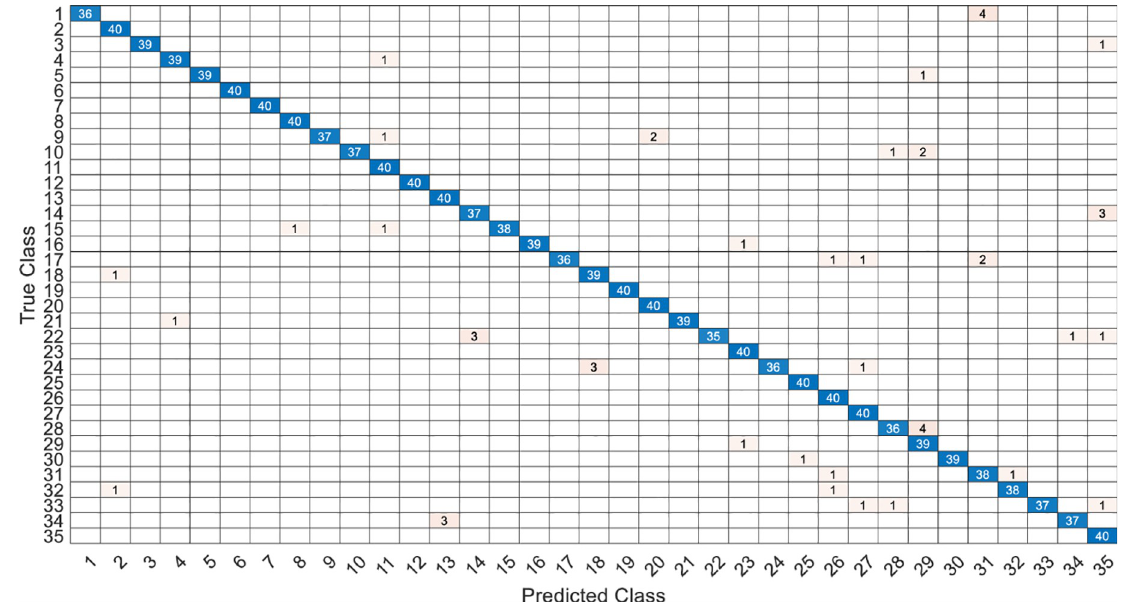
Fig 34. The confusion matrix of PCA-DNN-12-layer model with MFCC datasets.